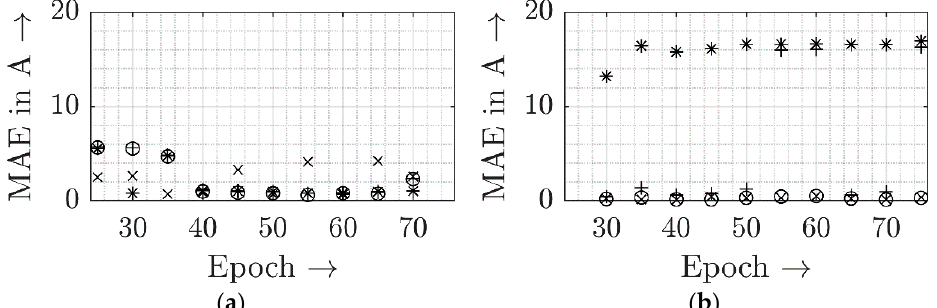
Figure 5. Mean square error over number of epochs for ( a ) Nadam and ( b ) NAG for validation data set 1 (“x”), validation data set 2 (“+”), validation data set 3 (“o”) and validation data set 4 ( “ ∗ ”).